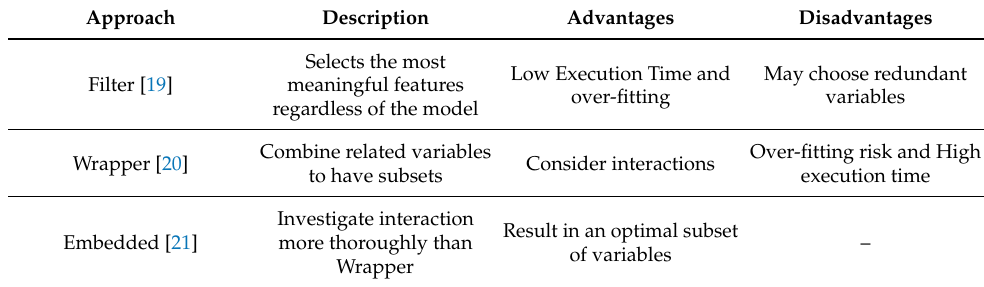
Table 3. Feature selection